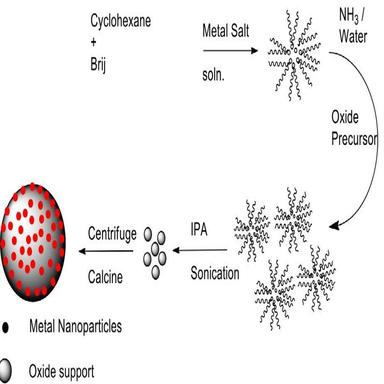
Reverse micelle microemulsion technique for the synthesis of supported metal nanoparticles.